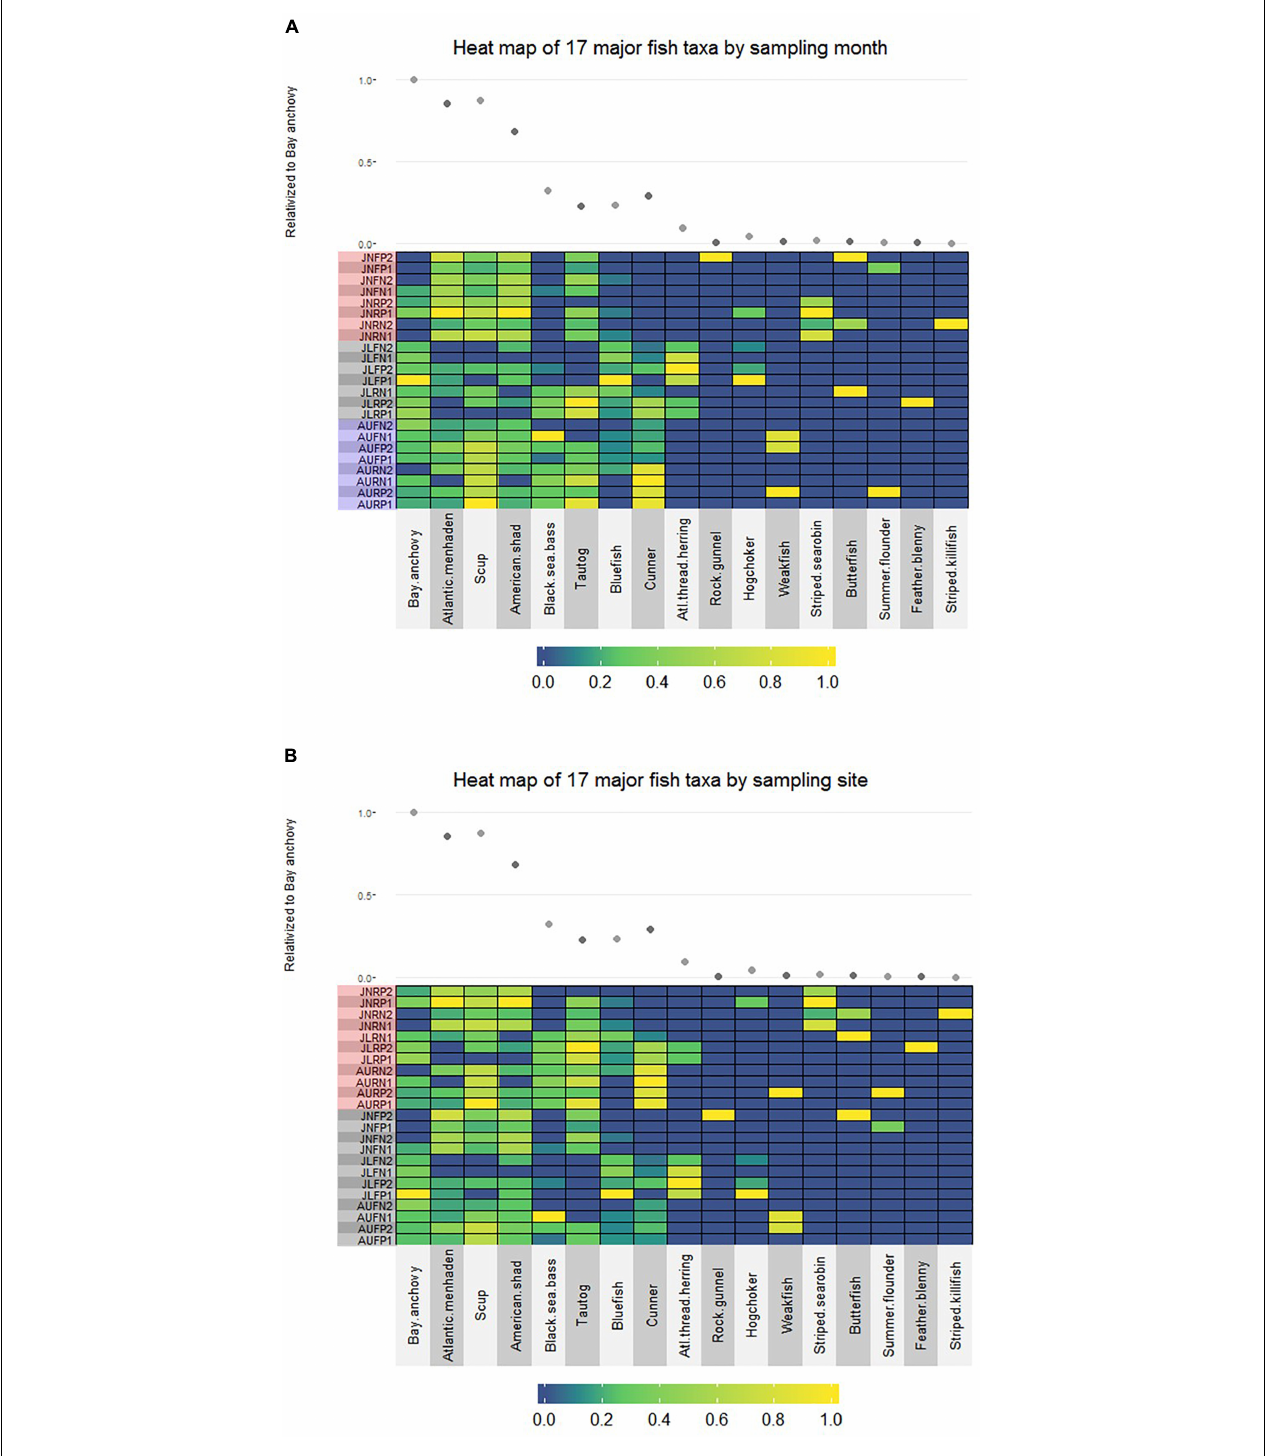
FIGURE 2 | (A) Relative abundance of 17 major finfish taxa (JN: June; JL: July; AU: August; F: Farm; R: Reef; N: Nylon; P: Polycarbonate) organized by sampling month (red shadow: June; gray shadow: July; blue shadow: August). For each taxon, read number of individual sample is relativized to the highest value within the taxon; the average read number of each taxon is relativized to that of the bay anchovy (scatter plot), the species with the highest sequence abundance across all samples. (B) Relative abundance of 17 major fish taxa (JN: June; JL: July; AU: August; F: Farm; R: Reef; N: Nylon; P: Polycarbonate) viewed by sampling site (red shadow: Reef; gray shadow: Farm). For each taxon, read number of individual sample is relativized to the highest value within the taxon; the average read number of each taxon is relativized to that of the bay anchovy (scatter plot), the species with the highest sequence abundance across all samples.